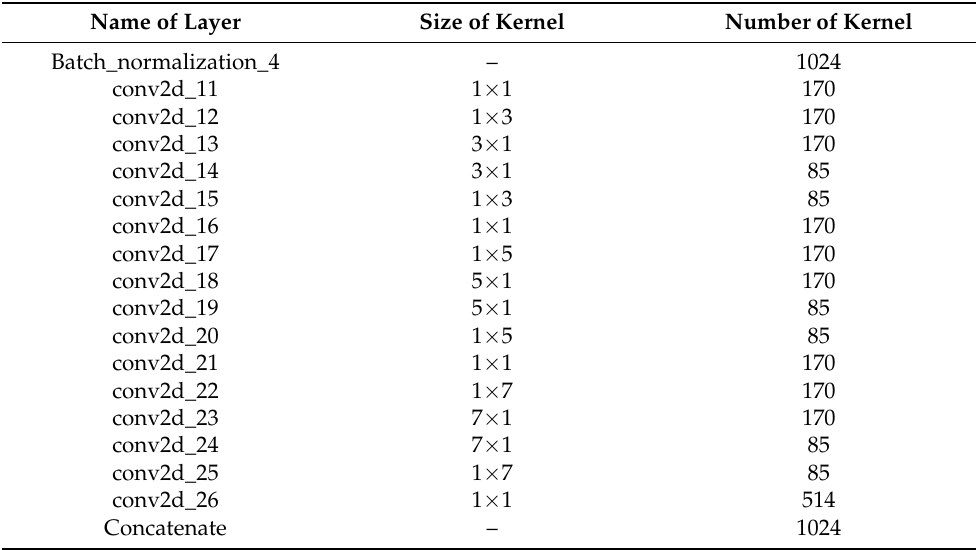
Table 2. MSCG convolution kernel parameter